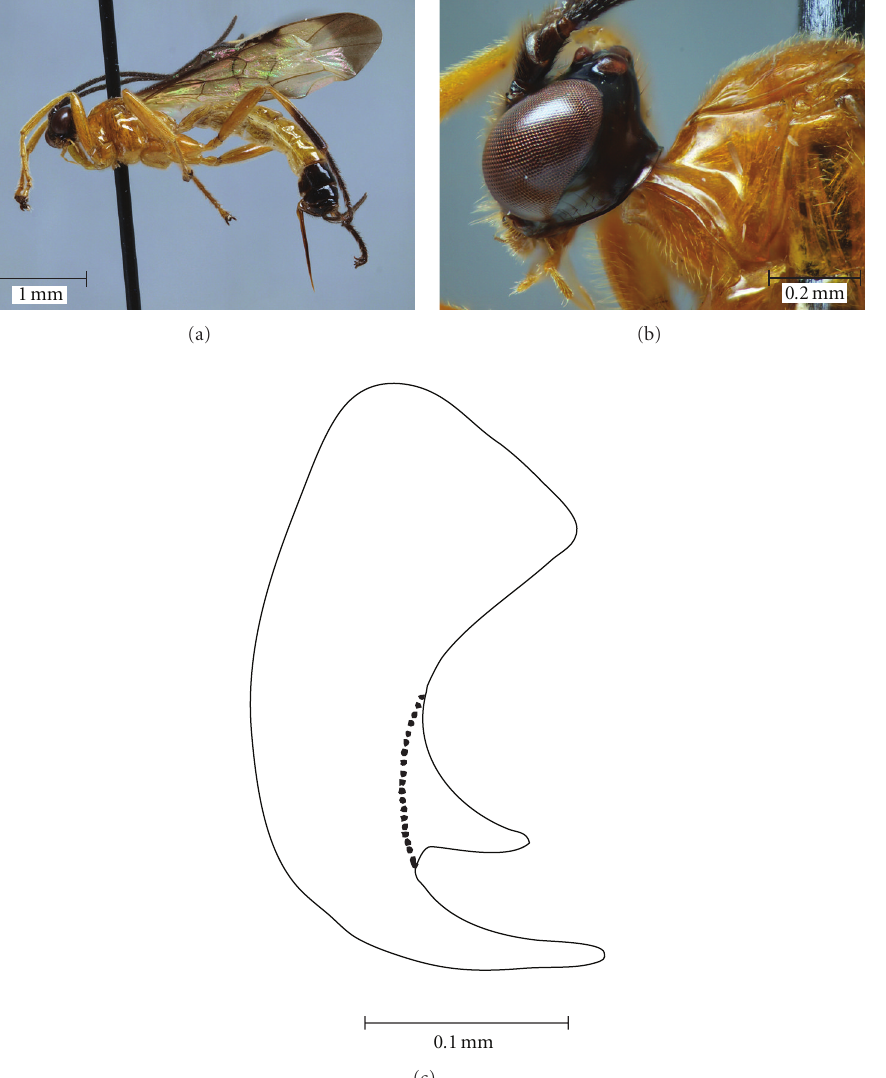
Figure 2: T. carinata sp.n.: paratype female habitus (a), occiput detail (b), and fore tarsal claw (c).